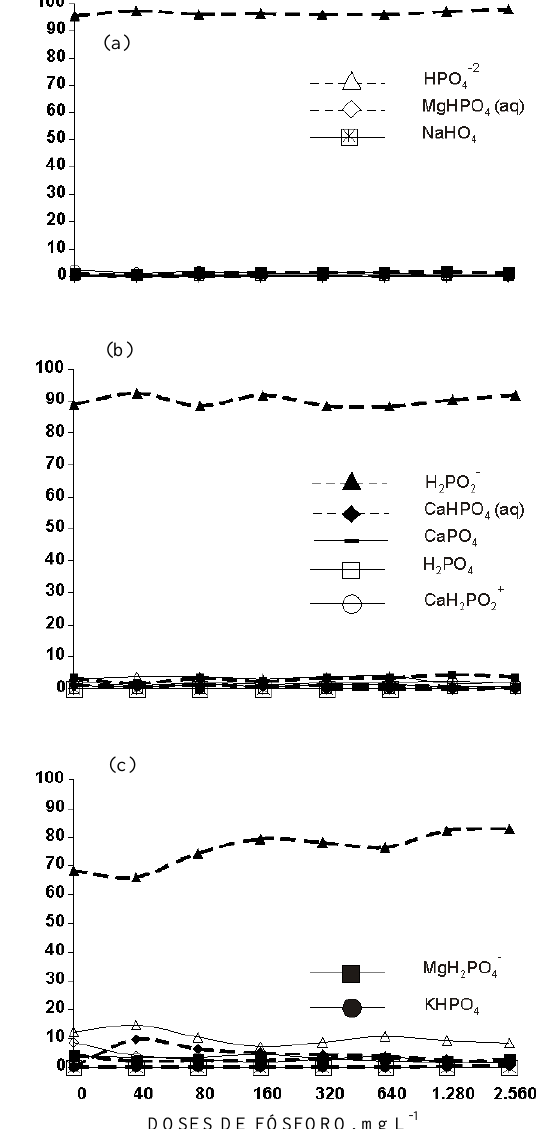
Figura 4. Concentração relativa de espécies de fosfato na solução de um Latossolo Vermelho distrófico típico, cultivado, por sete anos no sistema plantio direto em diferentes condições de acidez: pH 4,0 (a); pH 4,5 (b) e pH 6,4 (c) e submetidas a aplicação de doses de